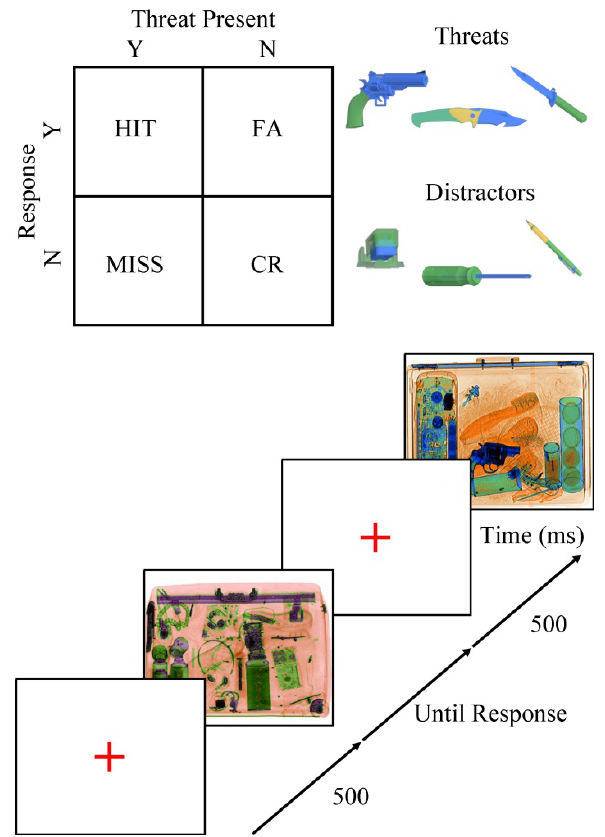
Figure 2 – Participants responded that threats were present by clicking on them with the mouse. When threats were present the trial was classified as a hit, and when they were not present they were classified as a false alarm (FA). Participants indicated no threat by pressing the spacebar key. In this case if no threat was present the trial was classified as a correct rejection (CR), and when a threat was present the trial was classified as a miss.